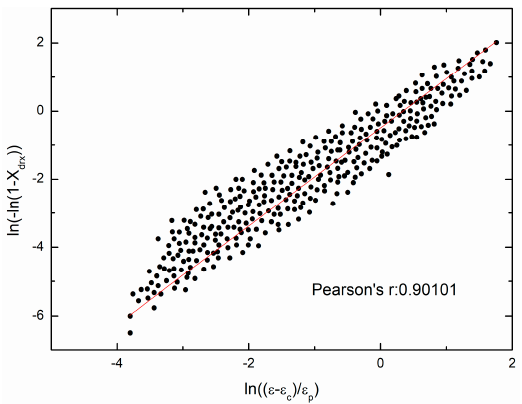
Figure 13. The - curves on different temperatures and strain rates: ( a ) 1/s; ( b ) 0.1/s; ( c ) 0.01/s.